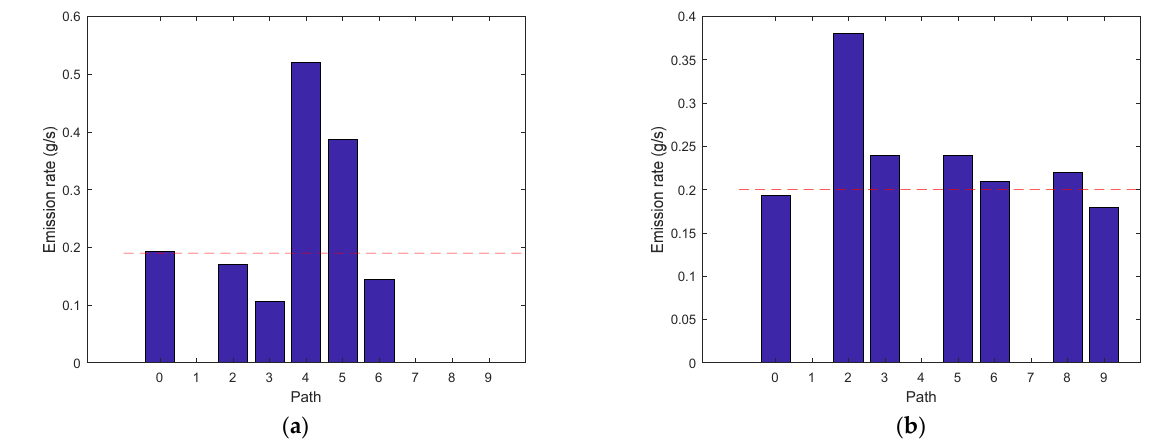
Figure 8. Emission rates based on multi ‐ path and single ‐ path observations: ( a ) Release One and ( b ) Release Two. Path 0 represents result from the multi ‐ path inversion. The horizontal dashed line shows the real emission rate.